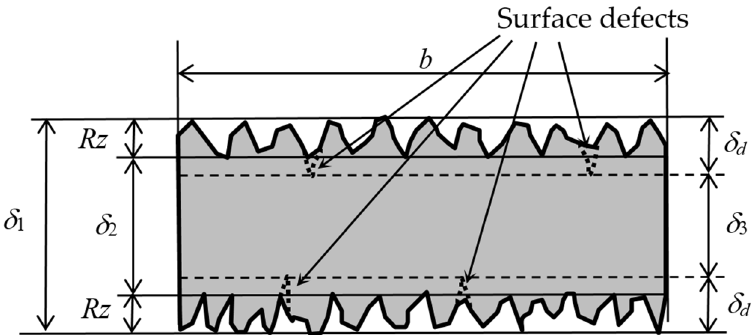
Figure 15. Schematic diagram of the thickness of the specimen for the calculation of the bending stress. Table 2. Fatigue strength considering the roughness and defect of the as-built Ti6Al4V manufactured by DMLS and EBM and the Ti6Al4V manufactured by DMLS and EBM through cavitation peening (CP), laser peening (LP), shot peeing (SP), grinding (G), and cavitation peening after grinding (G + CP).